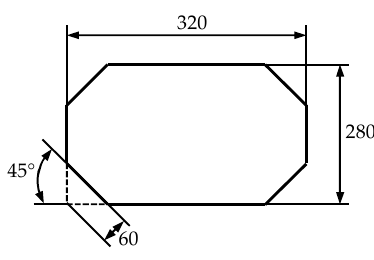
Figure A2. Forming limit diagram.